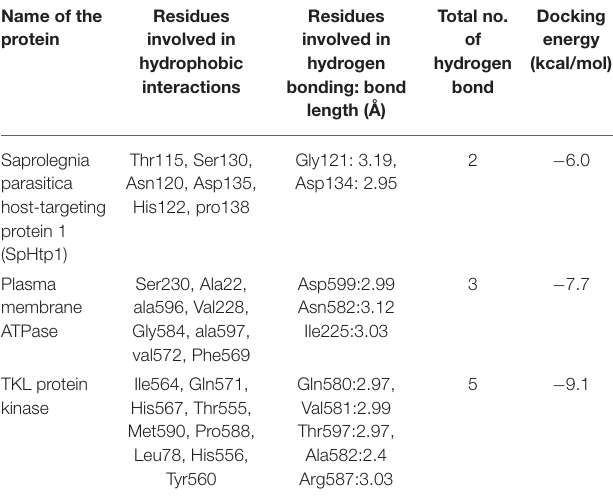
TABLE 1 | Details of interactions between Saprolegnia proteins and chlorhexidine gluconate (PubChem CID: 9552079). Name of the Residues Residues protein involved in involved hydrophobic interactions